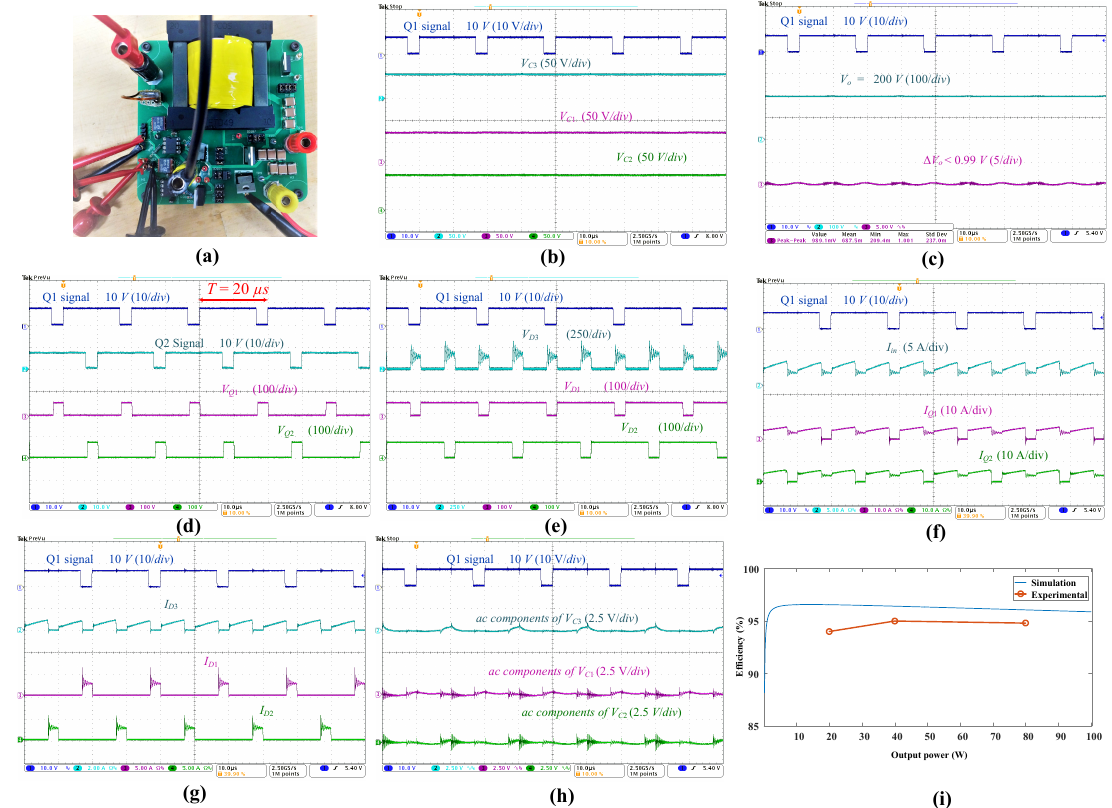
Figure 12. Experimental setup and results: ( a ) the experimental prototype; ( b , c ) capacitor voltages; ( d , e ) voltage stress across switching elements; ( f , g ) the current passing through switching element;s ( h ) the AC components of capacitors’ voltage; ( i ) the efficiency of the experimental